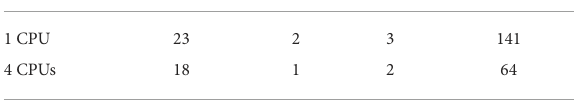
TABLE 6 The total running time of tools for classifying 500 genomes using a different number of CPUs. Time (min) PhaGCN MMseqs2 CAT vConTACT